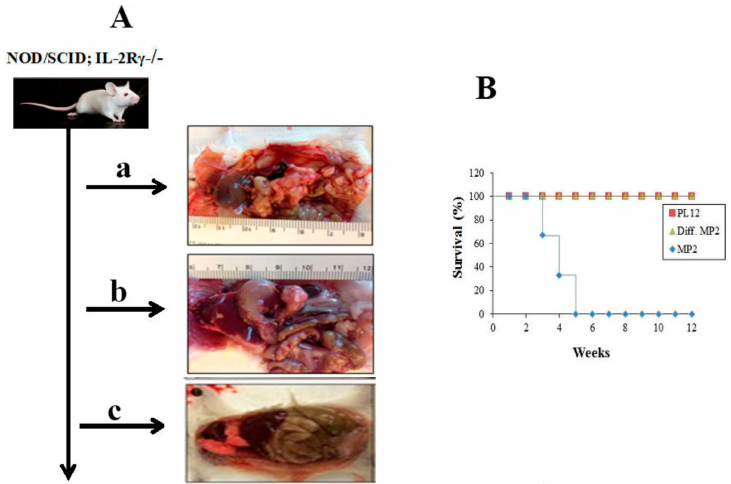
Figure 2. Lack of tumor growth, and long-term survival of NSG mice after orthotopic implantation of NK-di ff erentiated MP2 tumors in pancreas; MP2 tumors were di ff erentiated by the NK-supernatants as described in the Materials and Method section. MP2 tumors (3 × 10 5 ) ( n = 3) (panel a ), patient-derived di ff erentiated PL12 (2 × 10 6 ) ( n = 3) (panel b ), and NK-di ff erentiated MP2 tumors (di ff -MP2) (5 × 10 5 ) ( n = 3) (panel c ), were implanted into the pancreas of NSG mice and tumor growth were determined in 4 weeks for MP2 tumors and 12 weeks for PL-12 and di ff -MP2 tumors ( A ). The rates of survival of the mice in panels a, b and c ( B ) as well as tumor metastasis to liver (Supplementary Figure S2A) were determined after